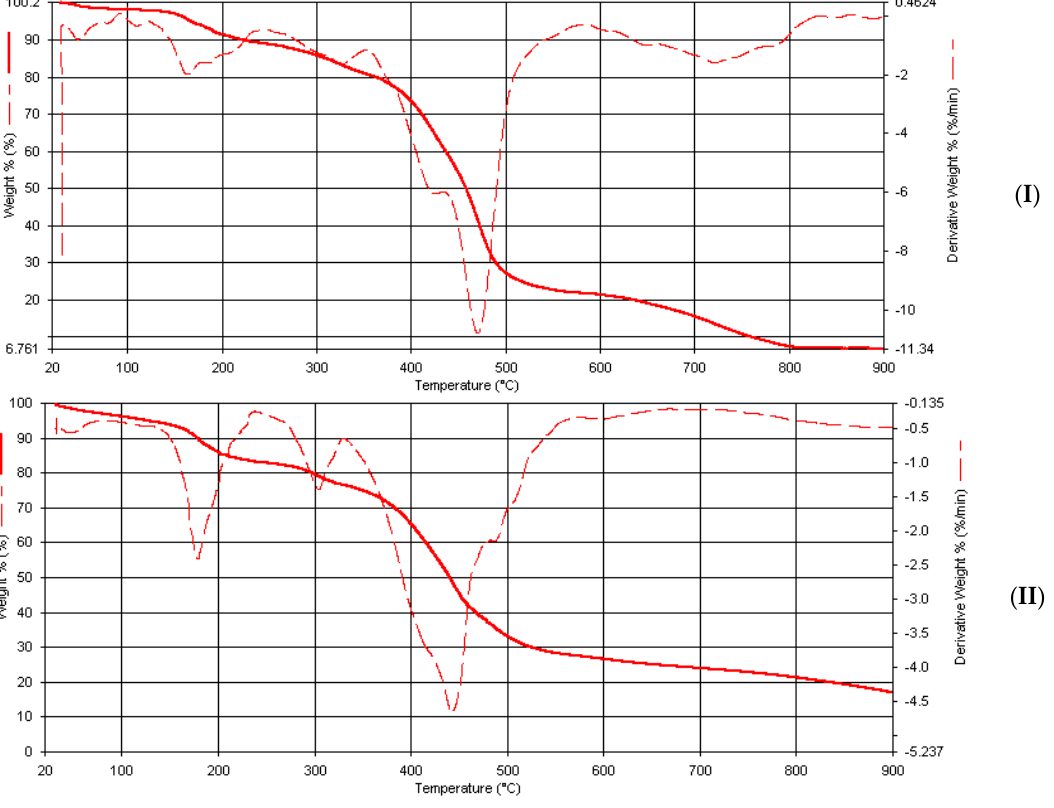
Figure 12. Thermogravimetric analysis curves of metal complexes. ( I ) Mn(Bmpp-Ph) 2 (H 2 O) 2 ∙ 2H 2 O; and ( II ) Co(Bmpp-Ph) 2 (H 2 O) 2 ∙ H 2 O